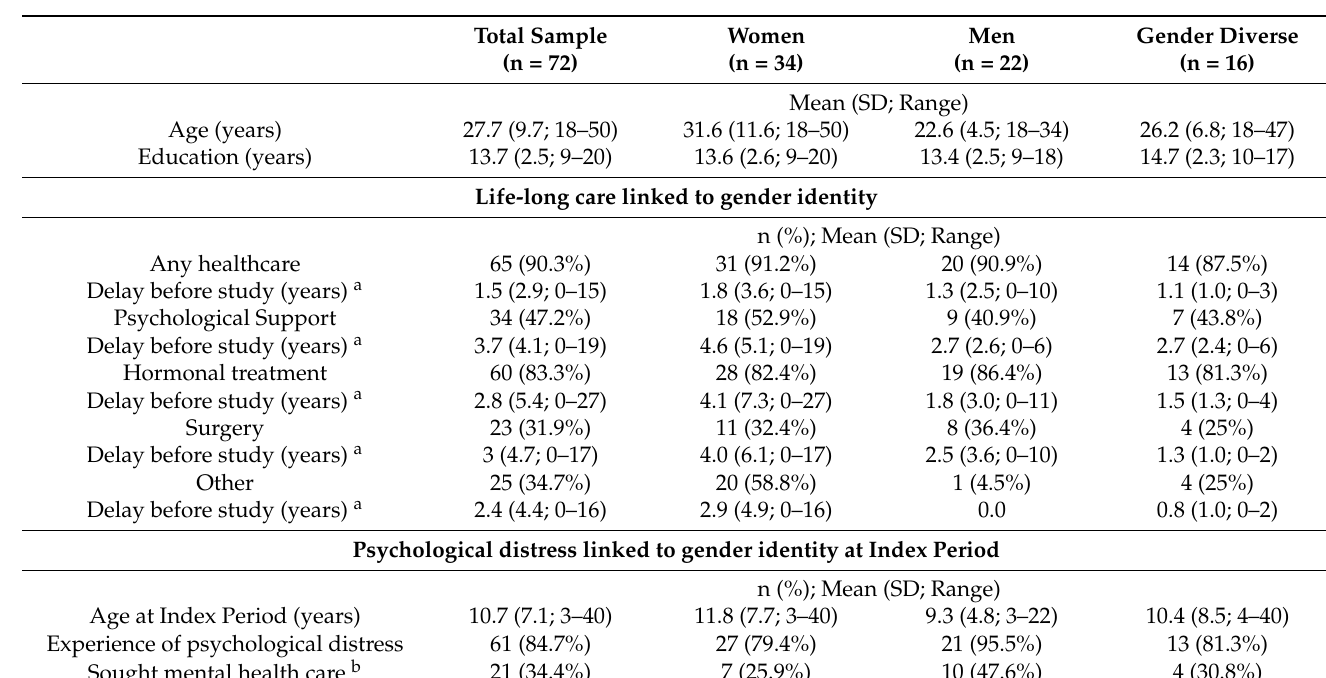
Table 1. Age, education, life-long care, and psychological distress at index period linked to gender identity according to current gender identity (women vs. men vs. gender